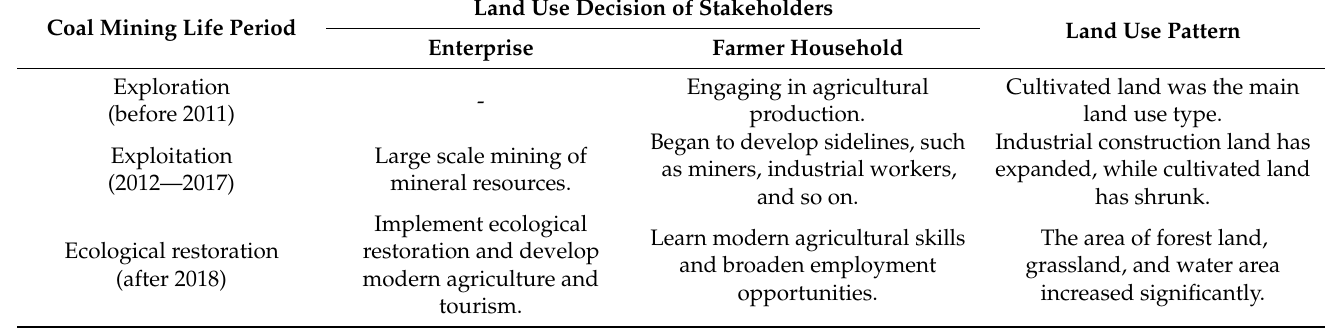
Table 3. The change in the land use decision-making actions of stakeholders in different coal mining life